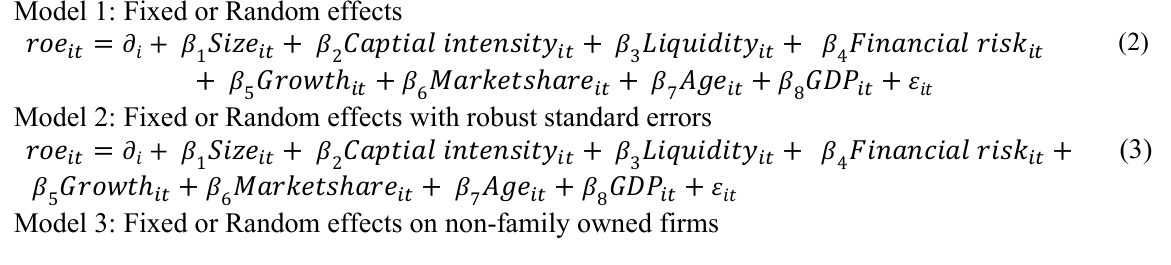
Model 1: Fixed or Random effects